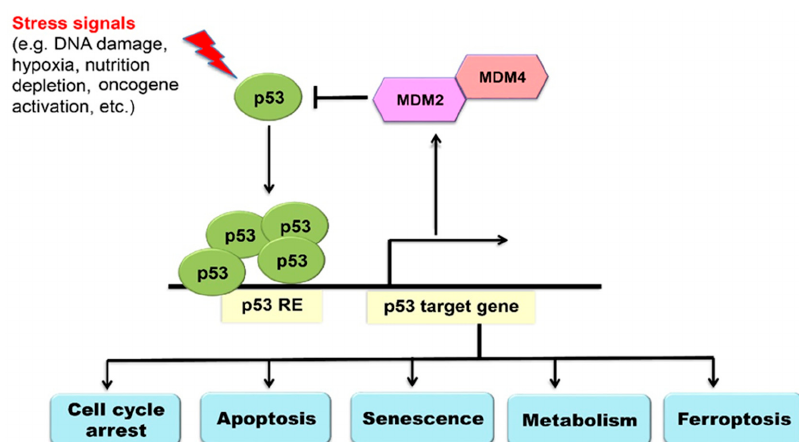
Figure 1. Tumor suppressor p53 signaling pathway. p53 protein is accumulated and activated in cells in response to various stress signals. Once activated, p53 transcriptionally regulates the expression of select target genes to regulate di ff erent cellular processes, including cell cycle arrest, senescence, apoptosis, metabolism and ferroptosis. MDM2 and MDM4 play a critical role in negative regulation of p53 in cells. p53 RE: p53-responsive